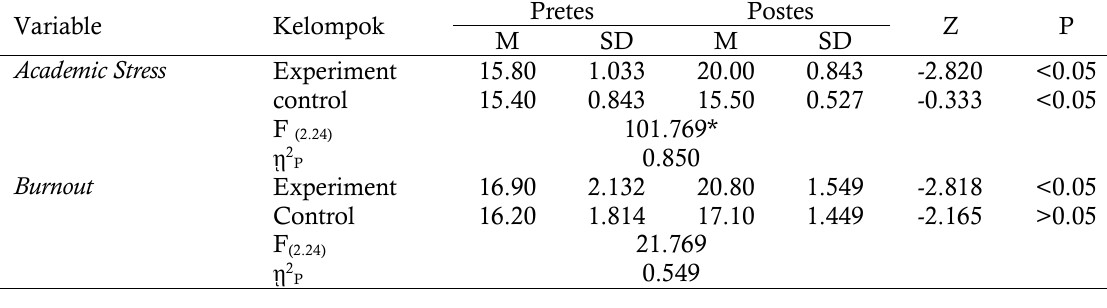
Table 1. The Results of Multivariate Analysis Test of Variance (Manova) and Wilcoxon